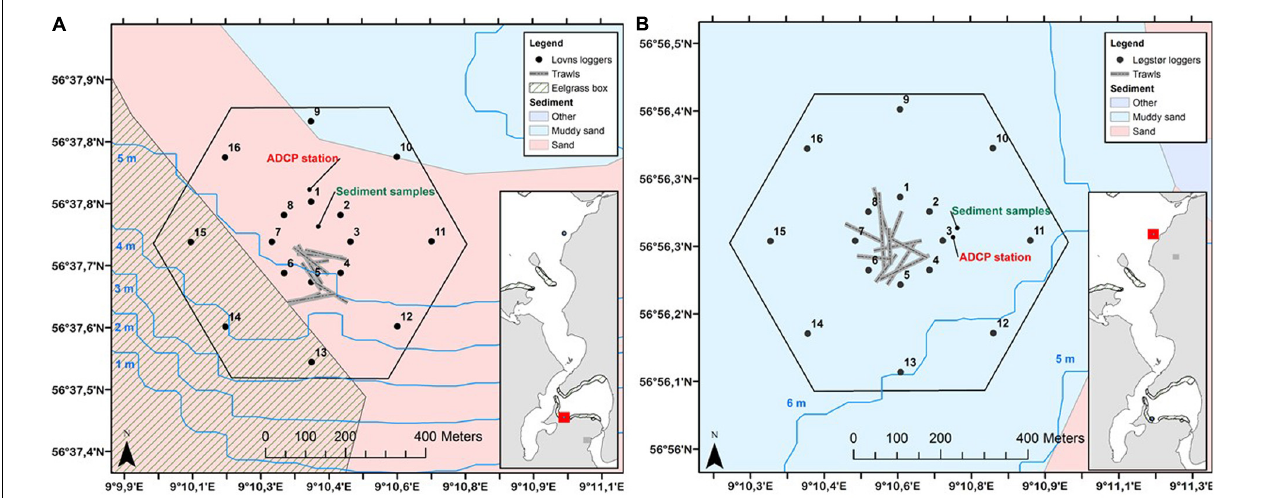
FIGURE 2 | Mussel dredging tracks conducted in (A) Lovns Bredning and (B) Løgstør Bredning. Black circles indicate the position of loggers (numbered from 1–16), the ADCP and the sediment sampling. Trawl tracks are gray lines, sediment types are indicated as background color, water depth as blue contour lines, and the FlexSem model domain is shown as a black polygon. The hatched area indicates the location of the eelgrass